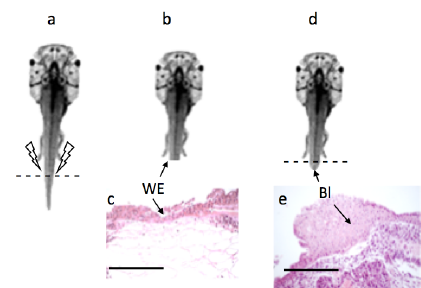
Figure 3. Wound healing and blastema formation: Following tail amputation at stage 57 (Figure 3a), wound was healed and two to three layers wound epithelium (WE) was formed in both the groups by 24 h (Figure 3b,c). By the 5th day, a mass of dedifferentiated cells was formed called blastema (BL) in both the groups (Figure 3d,e); scale bar 100 µ m. However, the size of the blastema was slightly larger in the experimental group compared to the control